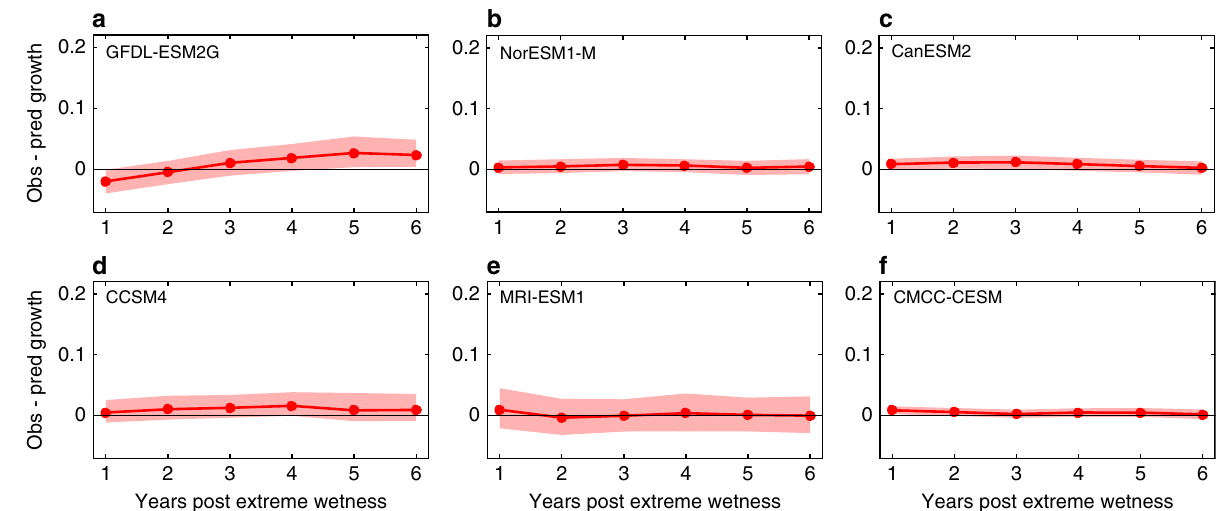
Fig. 4 Response to extreme wetness in woody biomass from six CMIP5 models. Growth change patterns after extreme wet years (exceeding the 95th quantile of the annual precipitation forcing data distribution during the analysis period) in the same grid cells in which the tree-ring chronologies were located (those signi fi cantly correlated with the climate indices) a – f . The models used included the Geophysical Fluid Dynamics Laboratory model (GFDL- ESM2G) a , the Norwegian Earth System Model (NorESM1-M) b , the Canadian Centre for Climate Model (CanESM2) c , the Community Climate System Model 4 (CCSM4) d , the Meteorological Research Institute model (MRI-ESM1) e , and the CMCC-CESM f . Shaded regions are the 95% con fi dence intervals around the mean from bootstrapping ( n = 5000